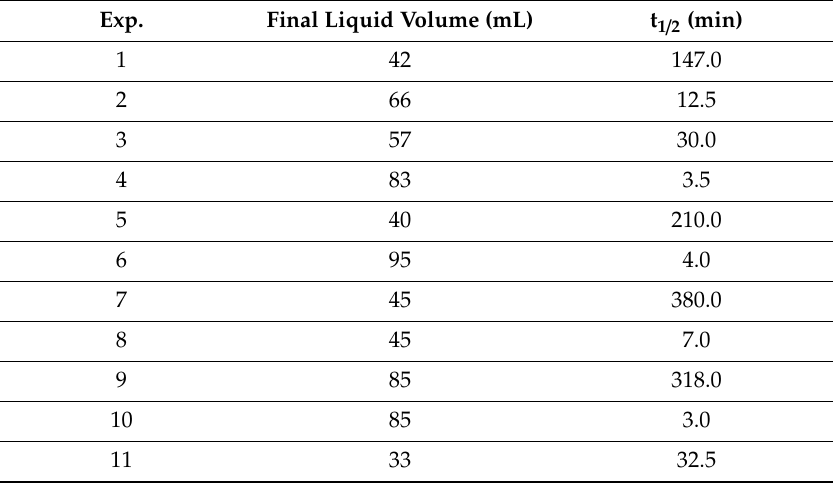
Table 4. Experimental design and observed